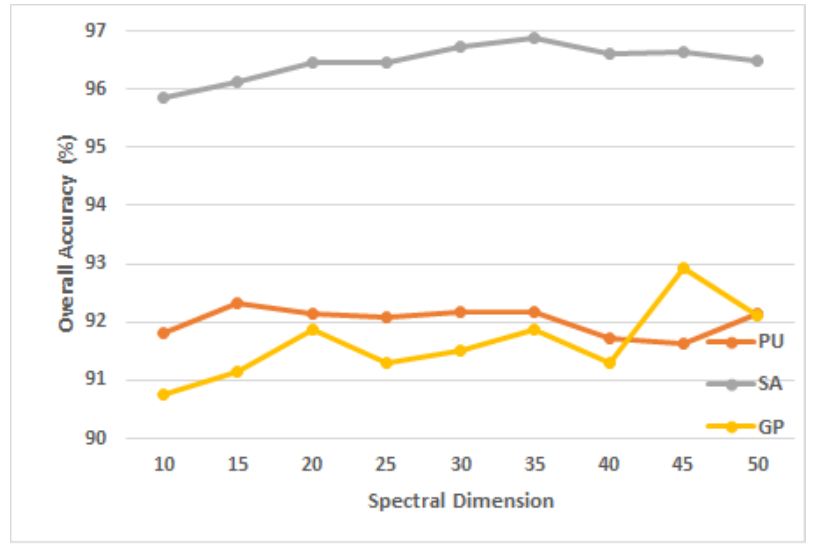
Figure 6. The OA of the proposed model using different spectral dimension in the three datasets.